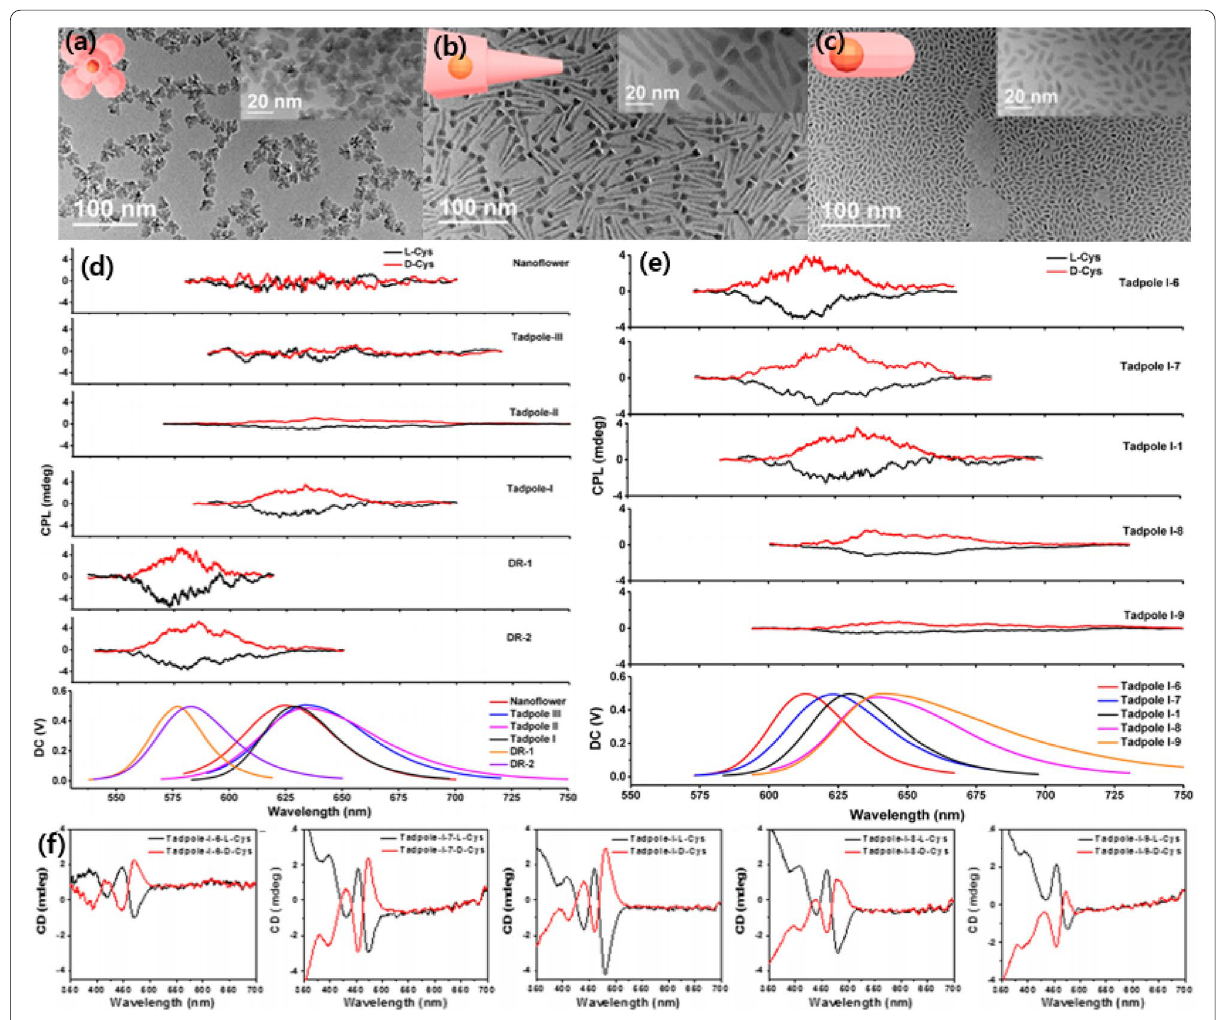
Fig. 14 a – c TEM of CdSe/CdS NPs with different shapes: a nanoflowers, b tadpole, c dot/rods, d Empirical CPP spectra of CdSe/CdS NPs with different shapes, e , f CPP and CD spectra of CdSe/CdS tadpoles with different length. Reproduced with permission from [81]. Note that empirical CPP spectra contain increasingly high contribution from differential scattering as the NMs becomes comparable to the wavelength of light as was observed for CLIPs in Fig. 13. Copyright American Chemical Society,